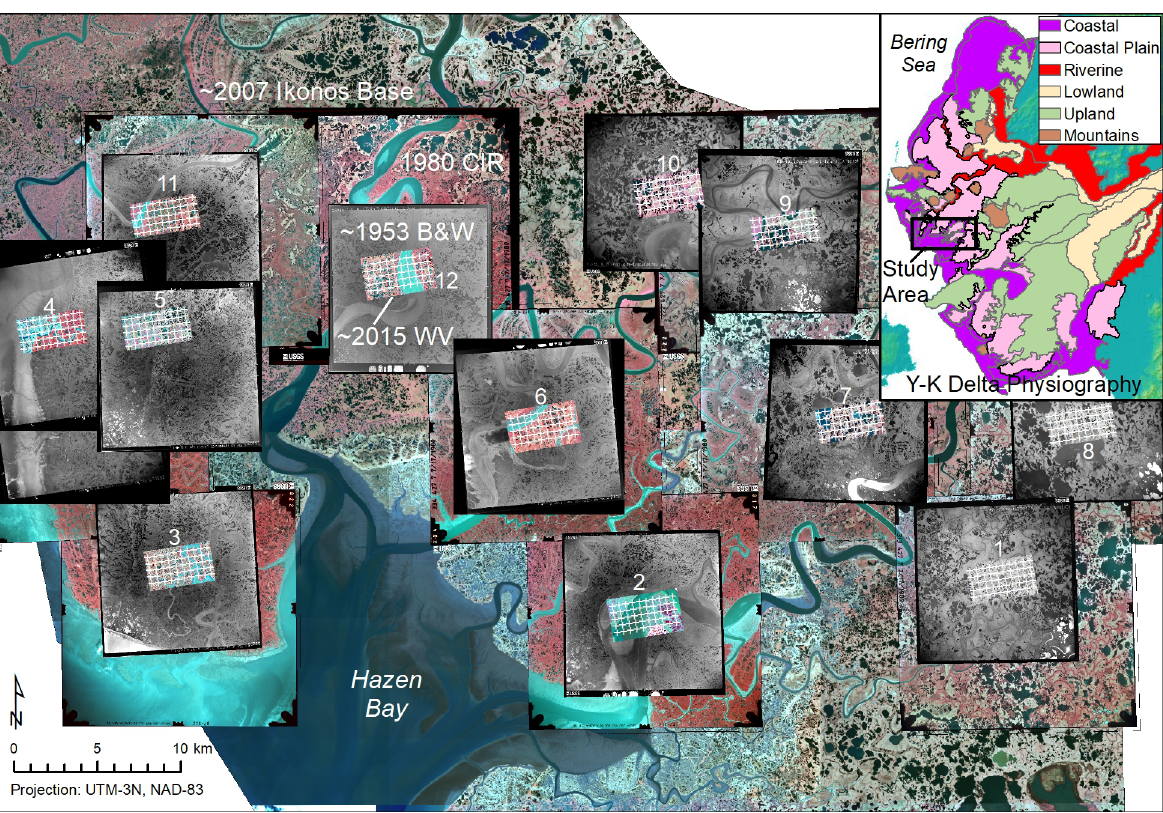
Figure A1. Sampling points (white crosshairs) within 12 grids located near the centers of historical air photos used for analyzing landscape change along the central coast of the YKD. The inset shows the coastal ecological subsections of the YKD and the study area boundaries. The imagery time-series included the 2007–2008 IKONOS ortho-mosaic and the overlapping 1948–1955 panchromatic (B&W) and 1980 CIR air photos and the clipped 2013–2016 WorldView (WV) satellite images. The yellow line denotes the boundary of the 23 September 2005 storm flooding (from